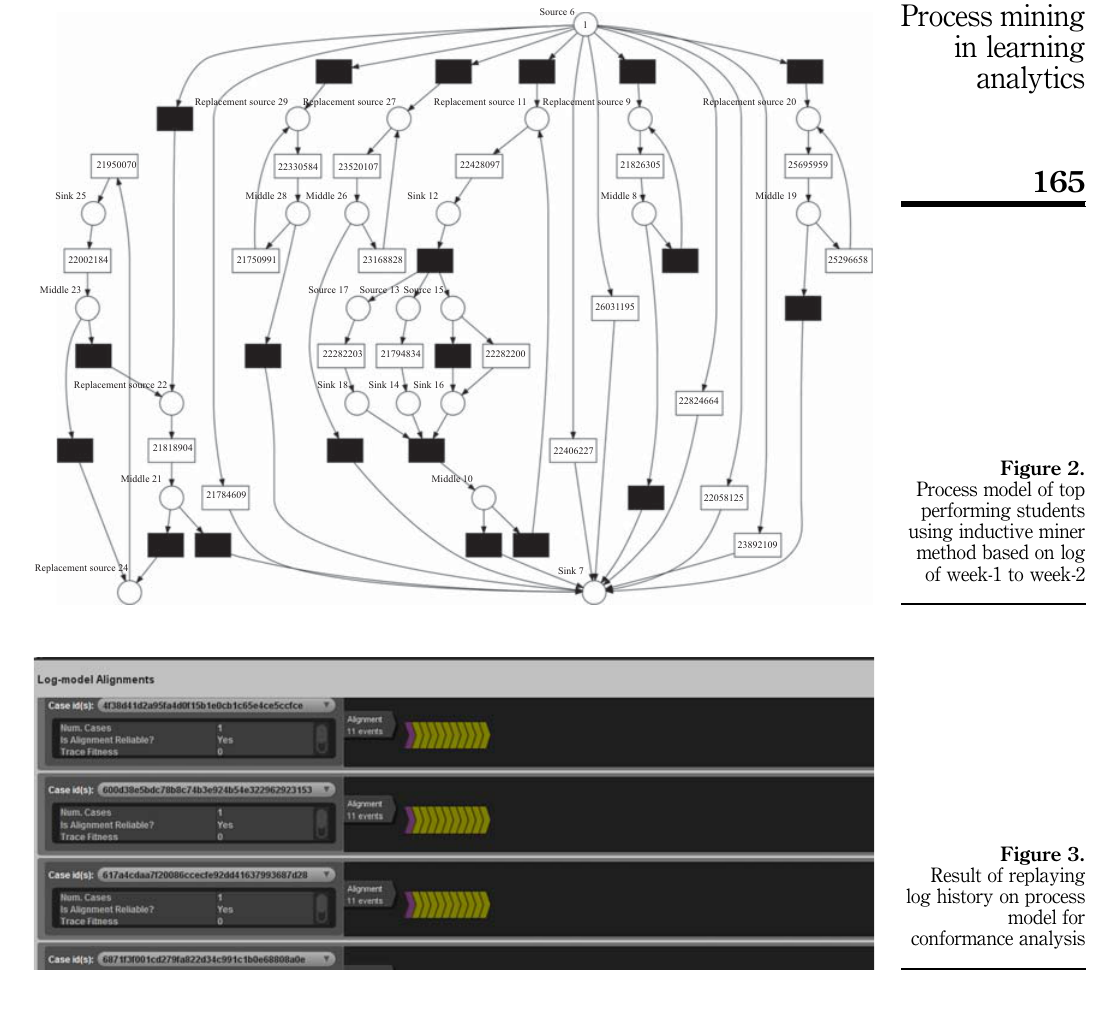
Figure 4. Screen-shot of